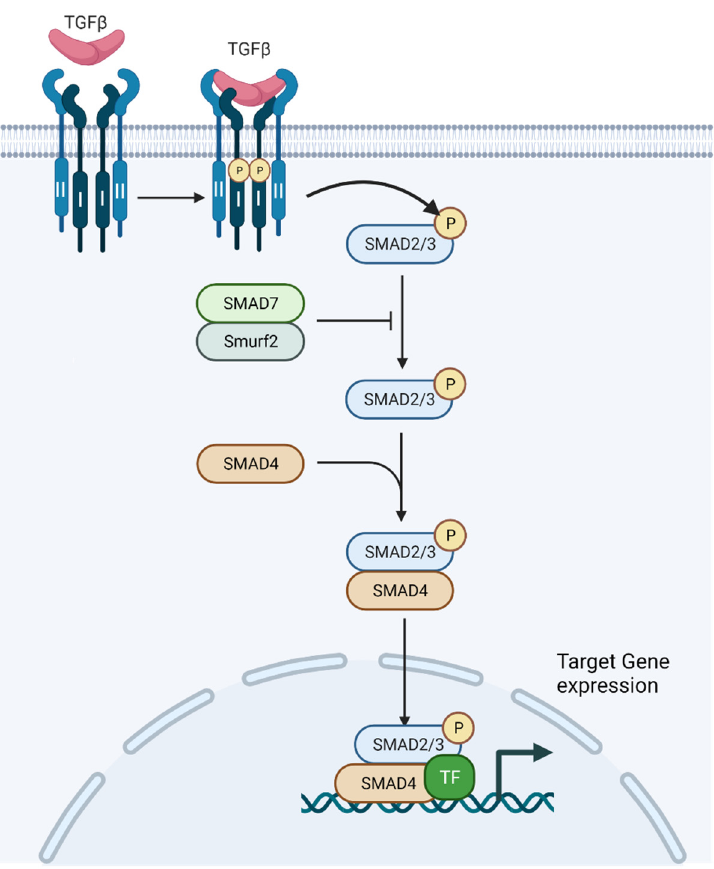
Figure 2. TGF- β signaling pathway (adapted from “TGF- β signaling”, by BioRender.com (2021). Retrieved from https://app.biorender.com/biorender-templates). Accessed 14 October 2021.